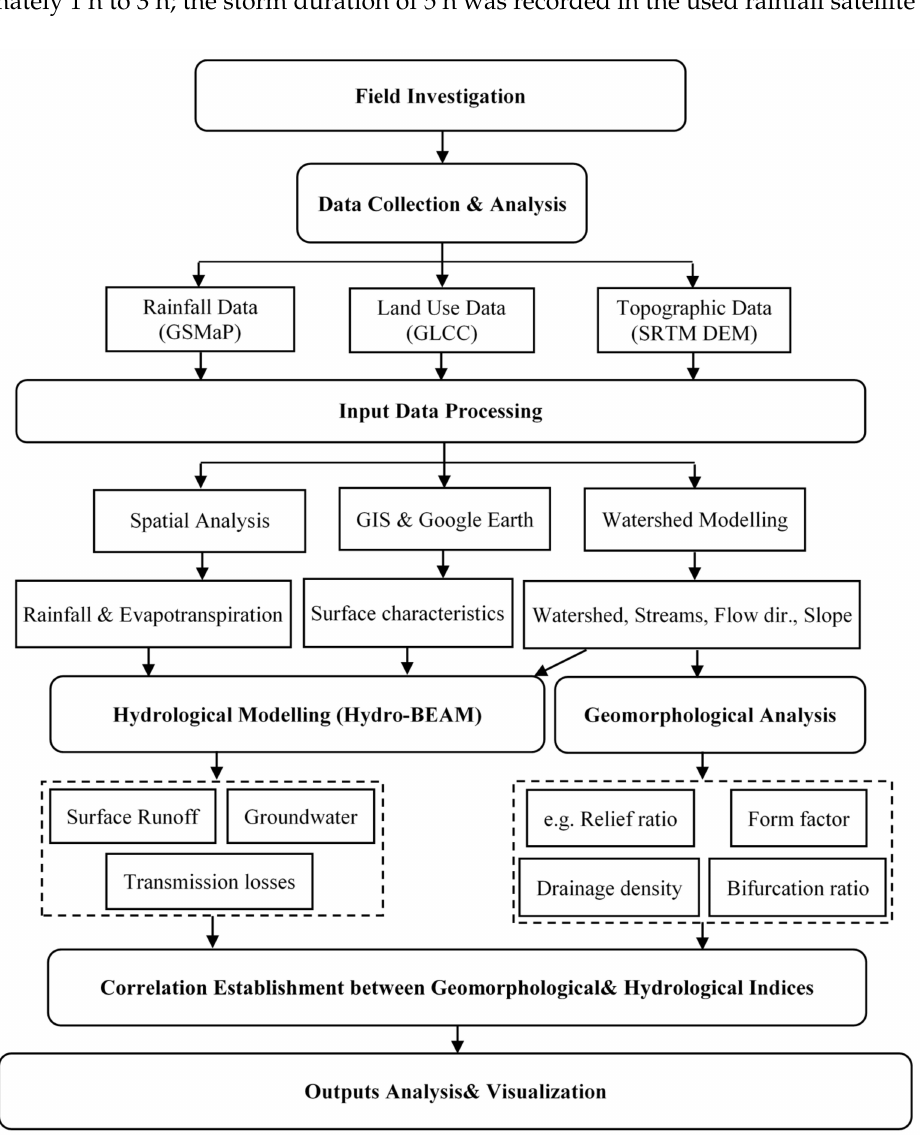
Figure 3. Simplified outline for the proposed methodology in this